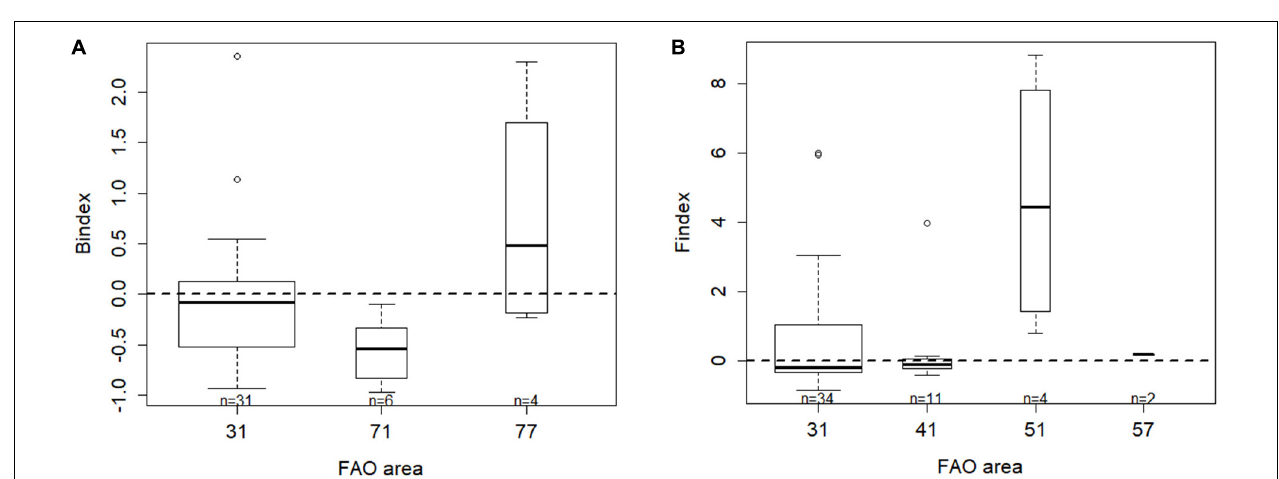
FIGURE 6 | Bindex (A) and Findex (B) values obtained for the FAO areas with a higher number of fisheries data available in the database. FAO major fishing areas: 31, Western Central Atlantic; 41, Southwest Atlantic; 51, Western Indian Ocean; 57, Eastern Indian Ocean; 71, Western Central Pacific; and 77, Eastern Central